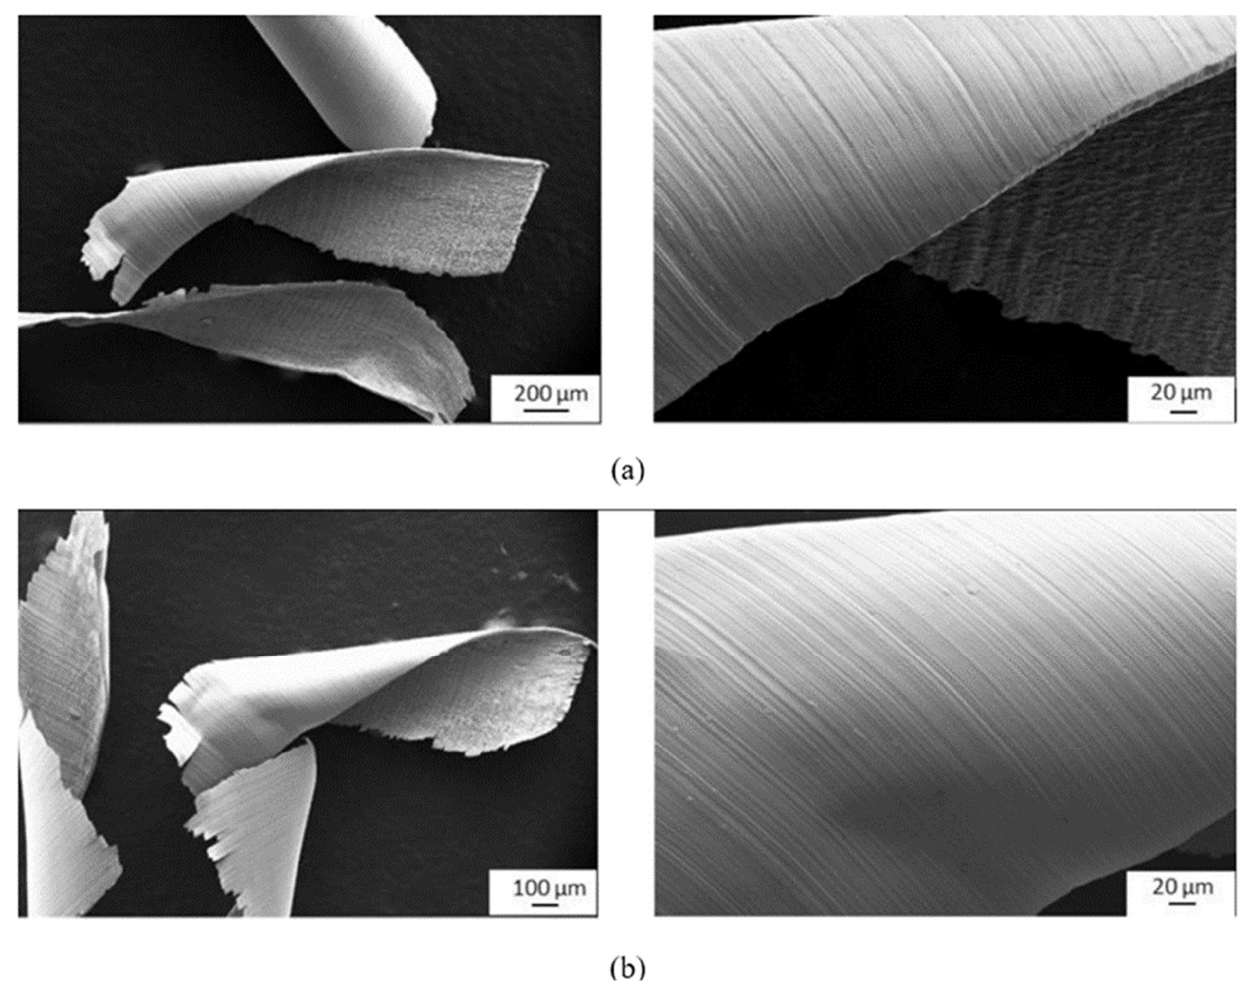
Figure 17. SEM micrographs showing the morphology of chips during the milling process: ( a ) conventional Ti-6Al-4V alloy and ( b ) SLM-formed Ti-6Al-4V alloy [121] (Reprinted with permission from [121]. Copyright 2020, Elsevier).